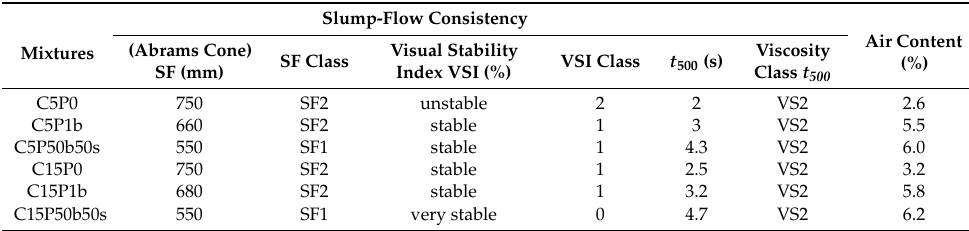
Table 8. Properties of the considered concrete